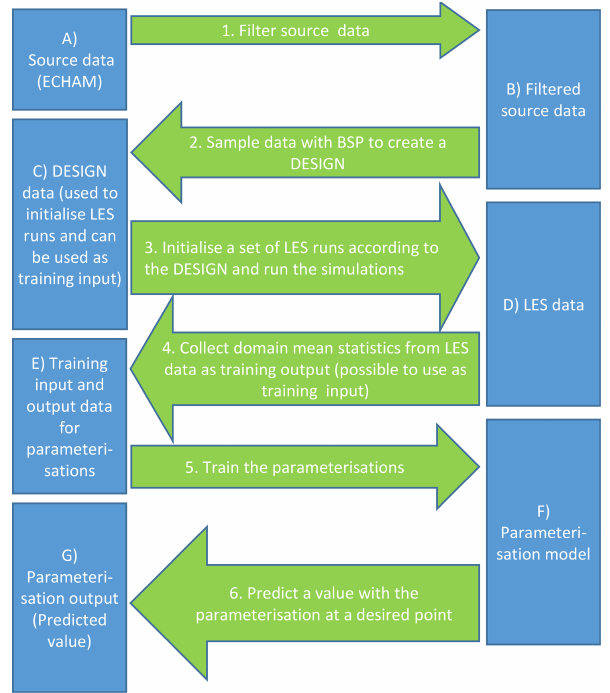
Figure 1. Pipeline of parameterisation